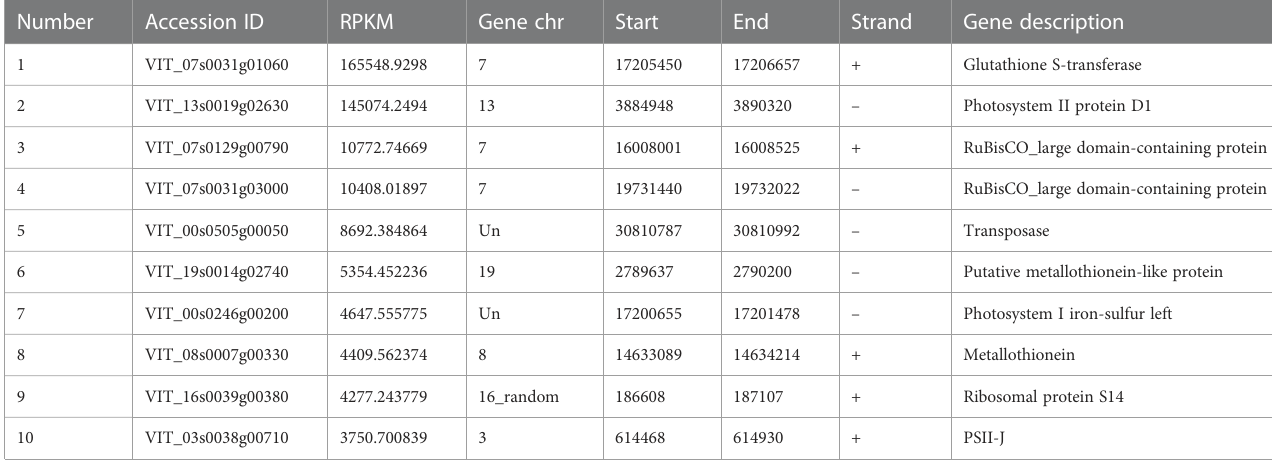
TABLE 1 The higher RPKM among all detected